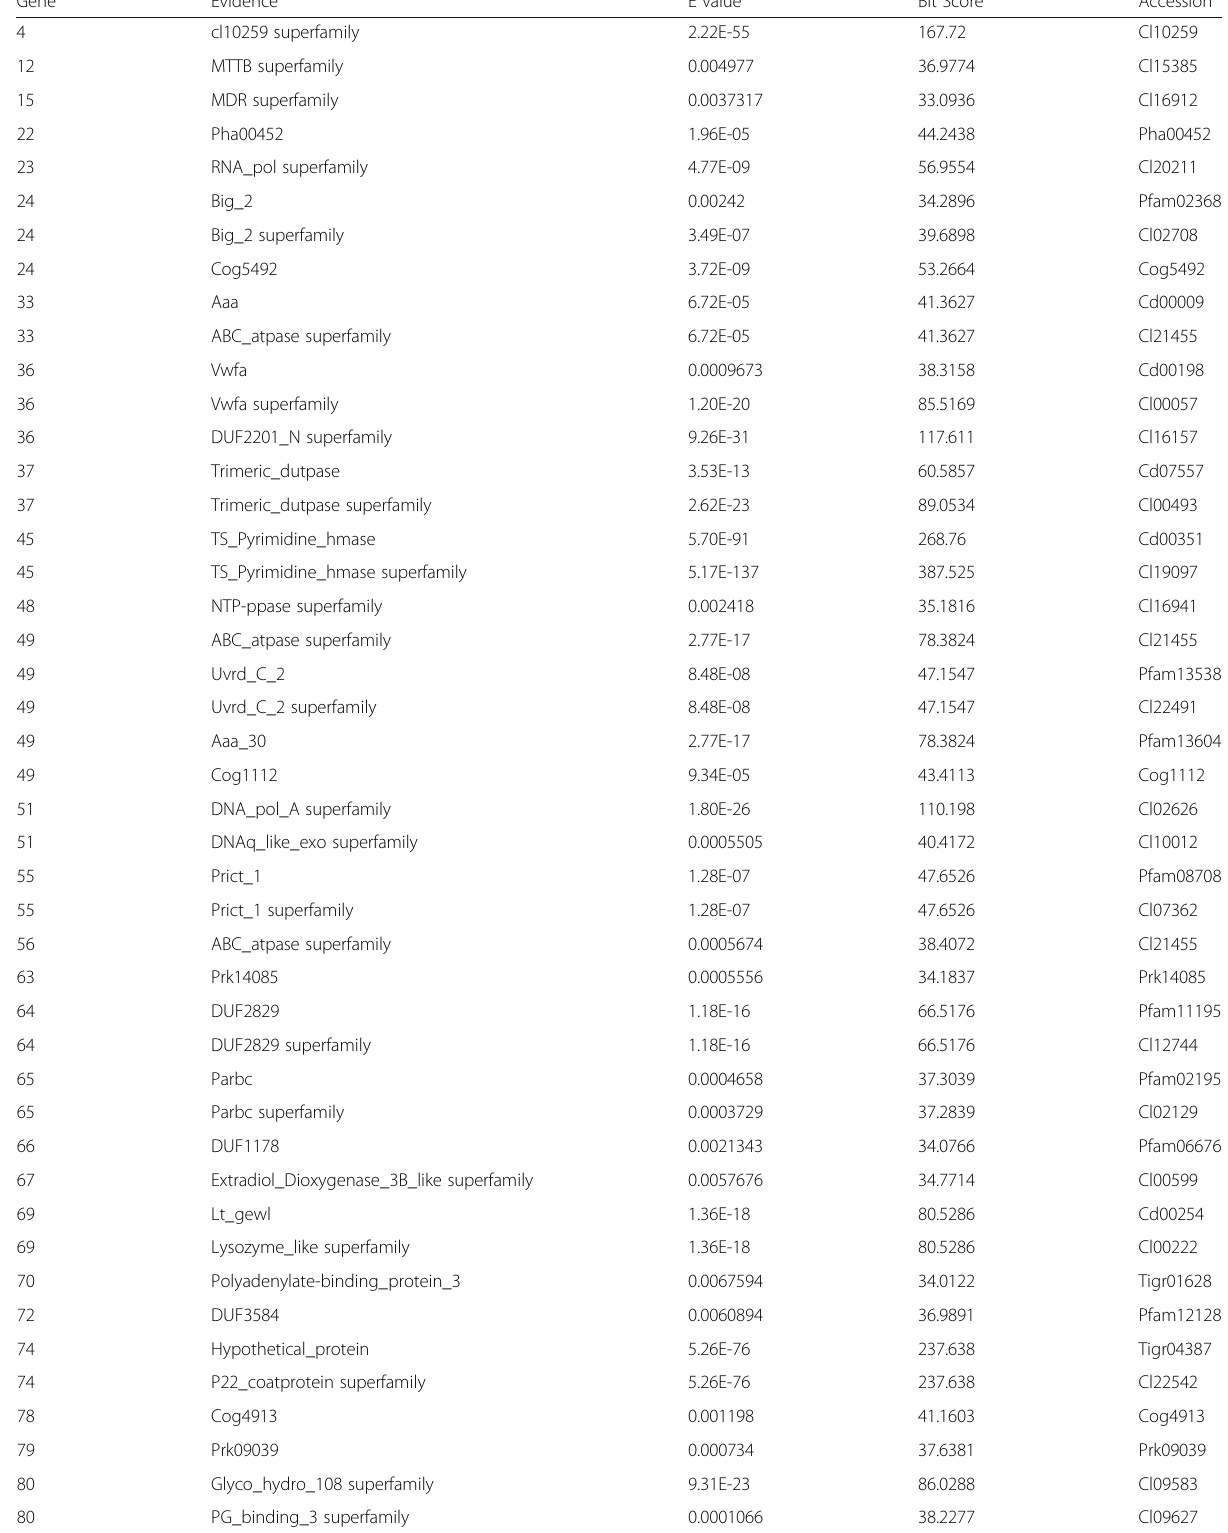
Table 6 Delftia phage RG 2014 annotation using conserved domain